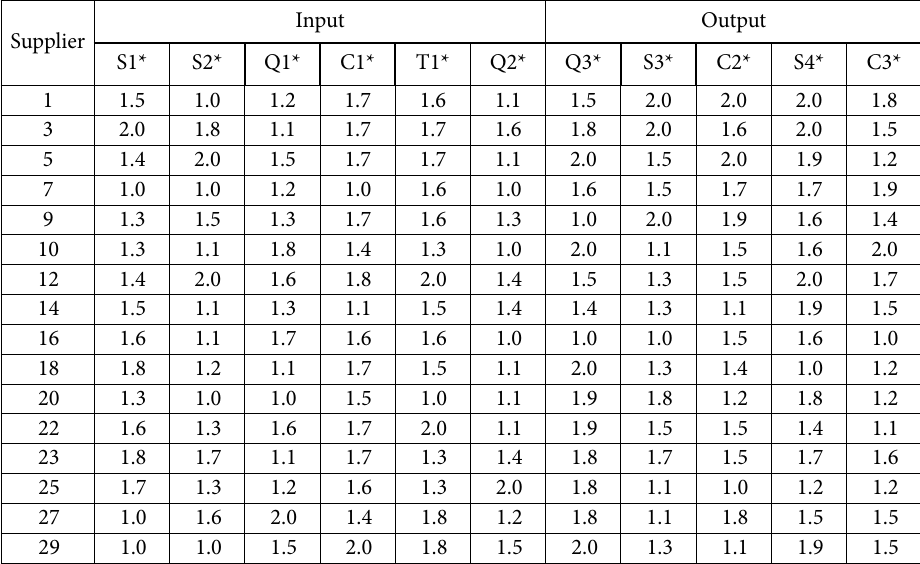
Table 11. Processed data of crankshaft for the DEA approach